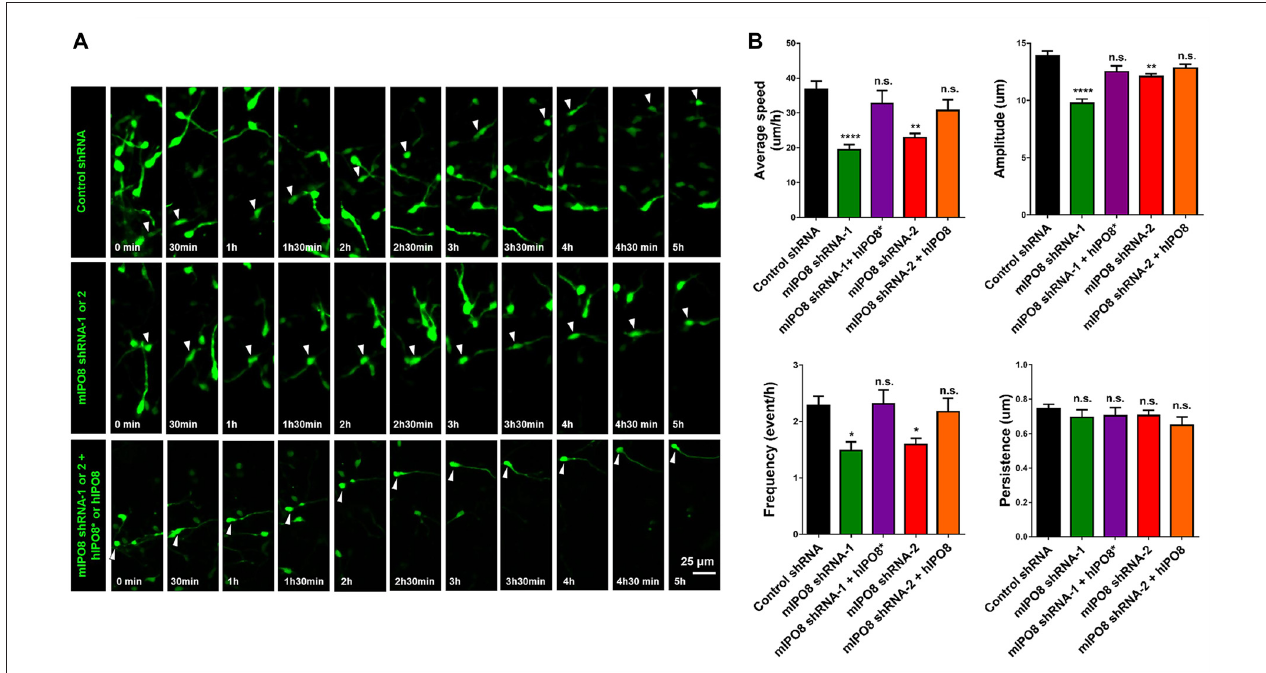
FIGURE 7 | Interneuron migration is decreased by acute IPO8 knockdown. (A) Typical recordings of the movement of interneuron expressing control or mIPO8 shRNA. MGE explants electroporated by shRNA/EGFP producing plasmids were cultured on cortical feeders for 1 or 2 days and were recorded by